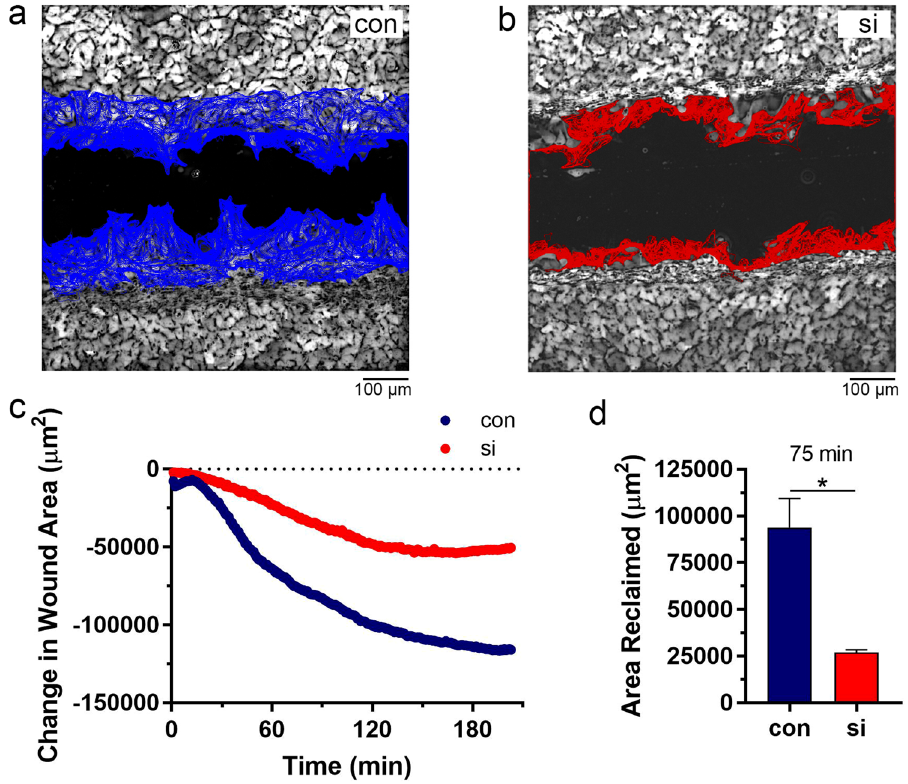
Figure 4. Reduction of RBM3 impairs wound healing. Scratch wounds were created in confluent cultures of 3T3 fibroblasts and wound closure was imaged in real time under homeostatic conditions. ( a and b ) Representative images of wounds and superimposed traces of fibroblast migration into the wound area in control ( a , blue) and RBM3 knockdown ( b , red) conditions. ( c ) Graph of the extend of wound closure as a function of time in the control (con) and RBM3 knockdown (si) experiments shown in panels a and b. ( d ) Graph summarizing group data on wound closure in terms of area reclaimed, normalized to scratch length, in control and RBM3 knockdown conditions (con, n = 4; si, n = 3; * p < 0.05 1-tailed